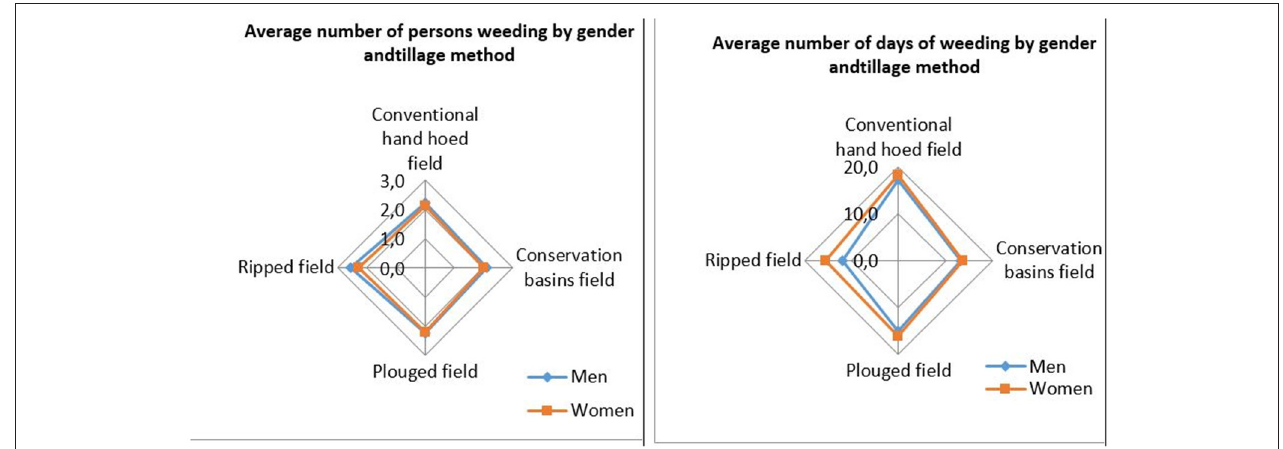
FIGURE 8 | Average number of adults involved in weeding and average days of weeding.